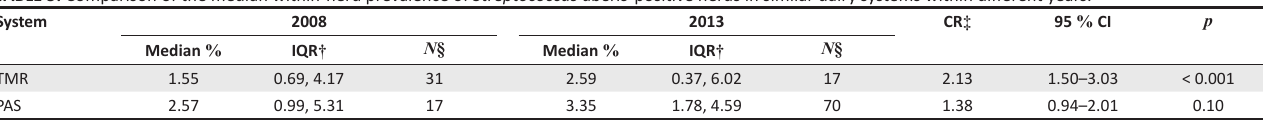
TABLE 5: Comparison of the median within-herd prevalence of Streptococcus uberis -positive herds in similar dairy systems within different years.